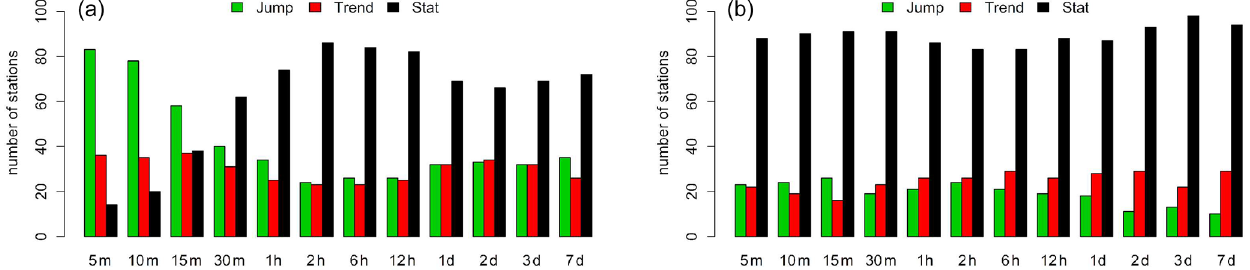
Figure 5. Number of long series (LS) stations that show stationarity (stat) vs. instationarity (either jump- or trend-like) at different duration levels following the instationary extreme value analysis; (a) before jump elimination and (b) after jump elimination between analogue and digital sensors. Table 4. Correction of the return periods (T[a]) when fitting the GEV to the annual maximum series (AMS) adapted from DWA